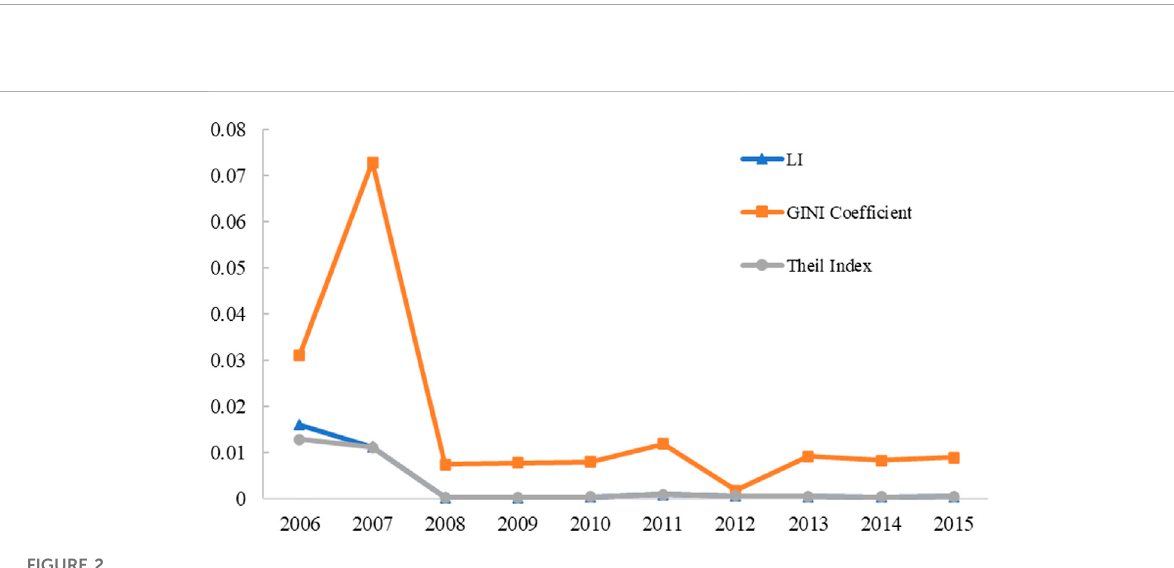
FIGURE 2 Trend of GINI coef fi cient, Theil index and